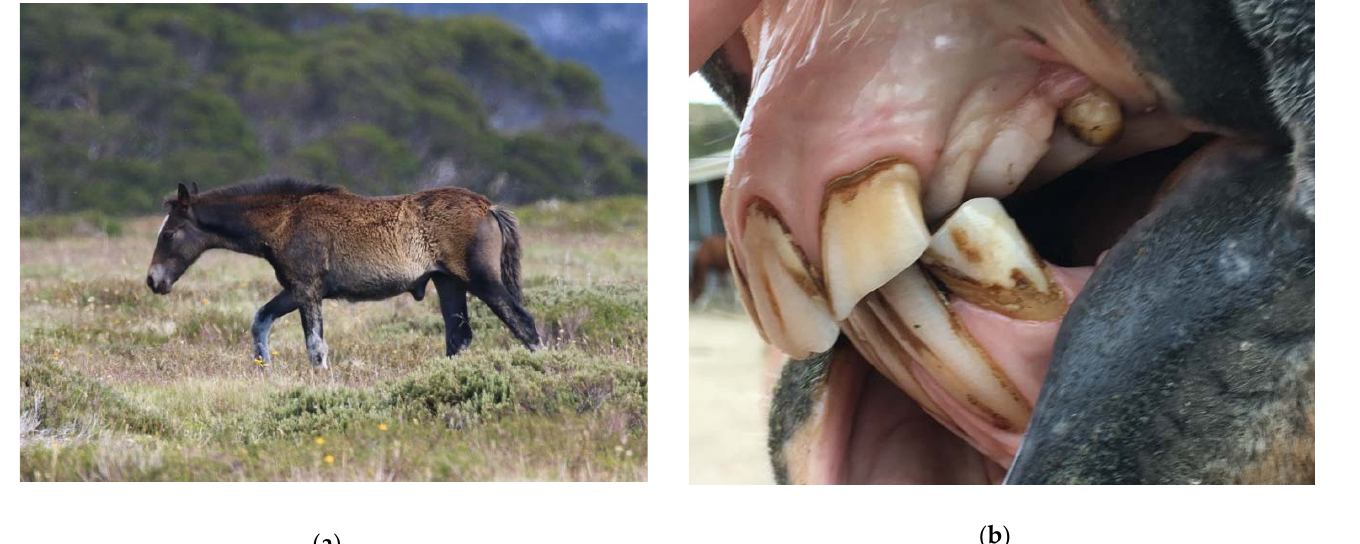
(Figure 7), pelvic limb deformities and cryptorchidism in Australian wild horses, which may be genetic in origin (personal observations).